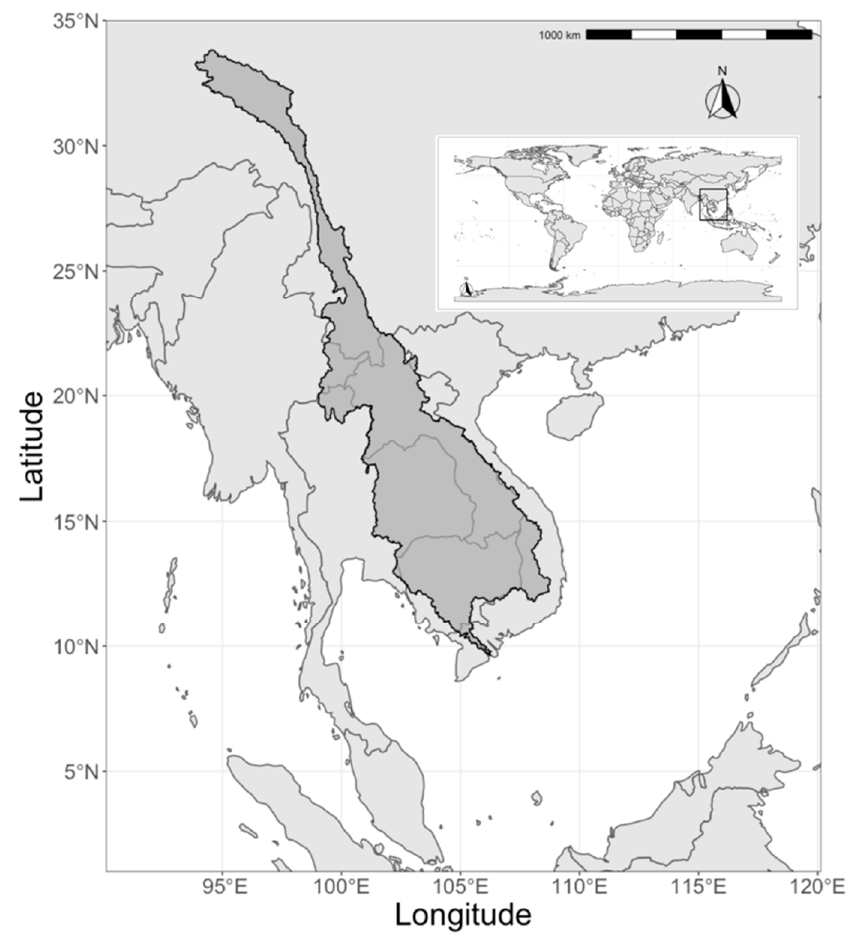
Figure 1. The Mekong River Basin (dark gray shaded area) is the longest river in Southeast Asia and flows through six countries: China, Myanmar, Thailand, Lao PDR, Cambodia, and Viet Nam. Black box of inset world map shows the enlarged region of the MRB. The Basin drains an area of 810,000 km 2 and the large biomass and diversity of freshwater fish recruited and harvested each year partially supports more than 40,000,000 people in the region [13].